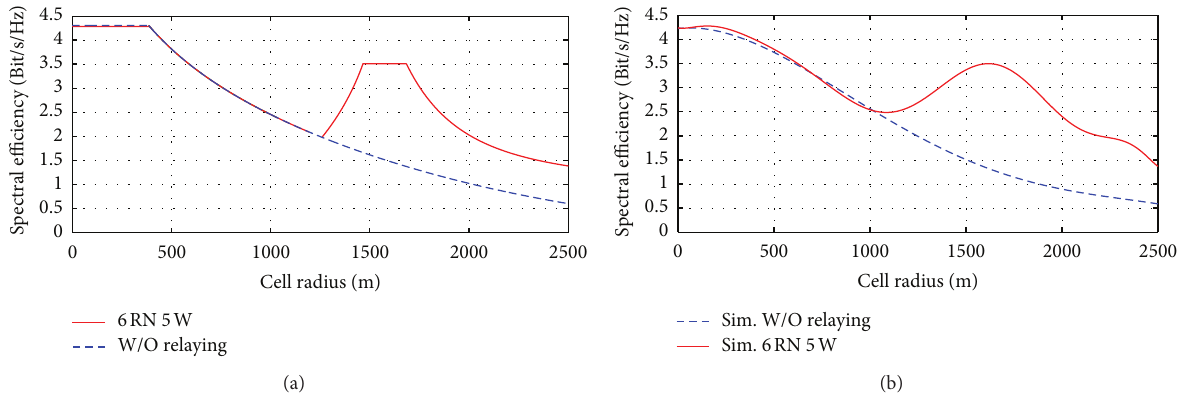
Figure 7: Spectral efficiency enhancement by deploying six RN at optimal location: (a) numerical and (b) simulation.